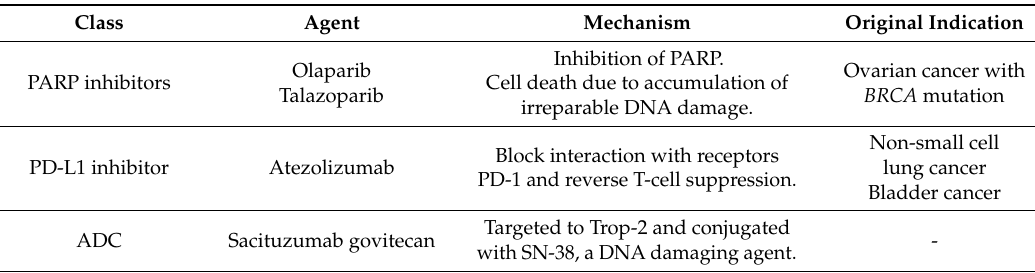
Table 2. Novel approved agents for metastatic